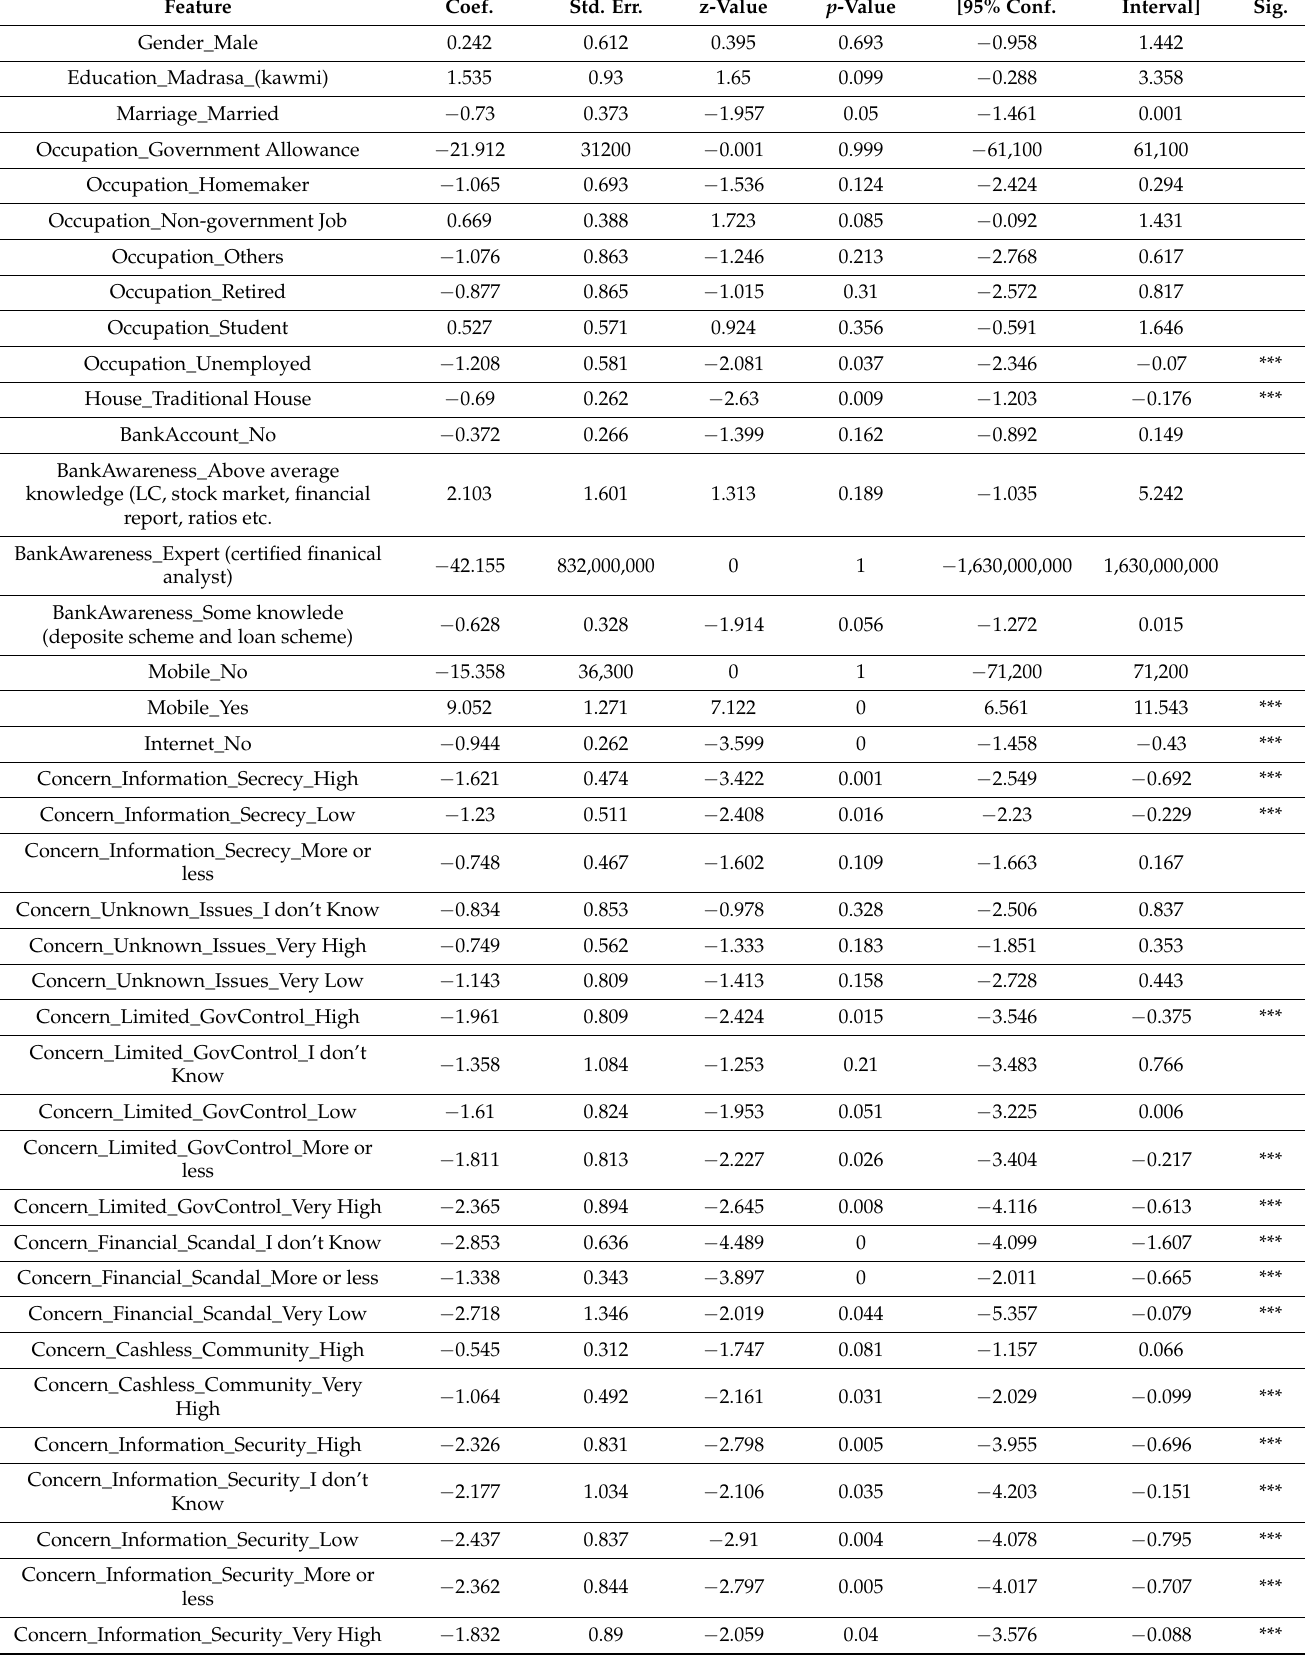
Table A3. Logistic regression results and feature significance